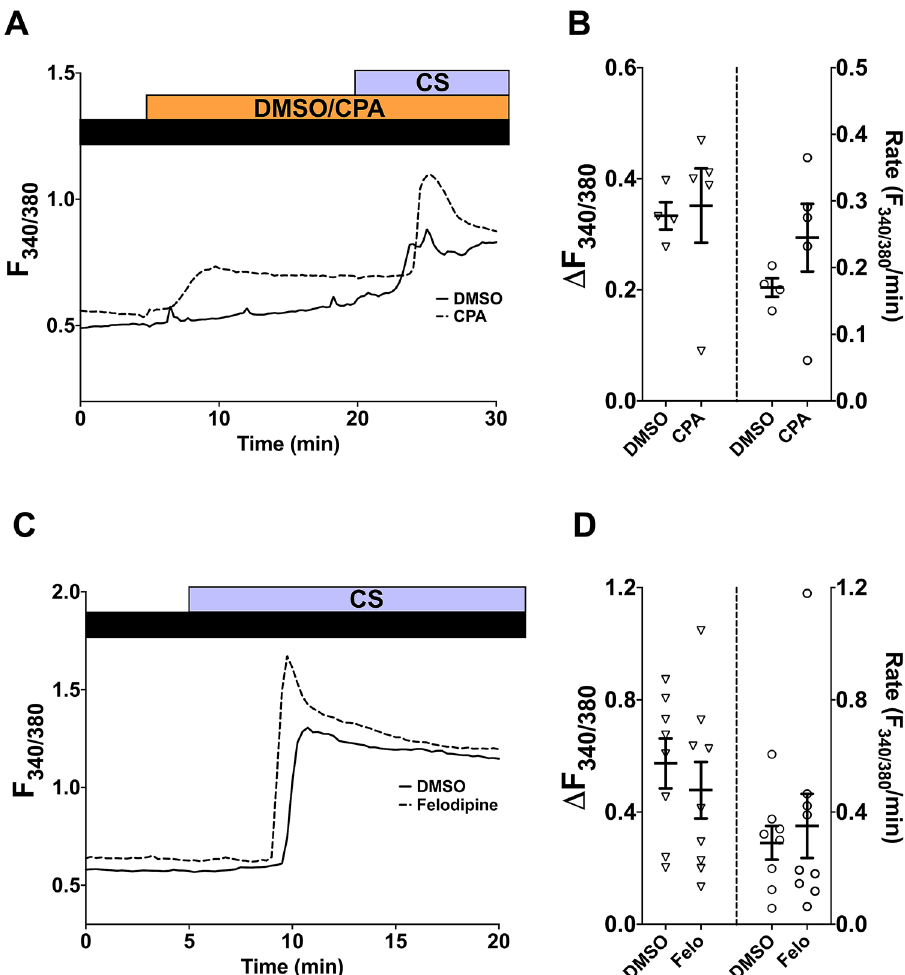
Figure 3. CS-induced Ca 2+ influx utilises a different pathway from SOCC and LTCC. (A,C) Representative Ca 2+ imaging traces from separate experiments tracking changes in [Ca 2+ ] i following puffing one whole cigarette after 15-min treatment with 10 µM CPA (A) , or after 10-min pre-treatment with 1 µM felodipine, which was also present throughout the experiment (C) . Equal volumes of DMSO (0.01% for CPA, 0.001% for felodipine) were used for vehicle control. Experiments were run in the presence of 1 mM extracellular Ca 2+ (black bar). (B,D) Summary of amplitude and rate of CS-induced [Ca 2+ ] i changes corresponding to experiments in (A,C) , respectively, presented as mean ± SEM. Unpaired t-test was performed between the CPA-treated group ( B ; 2 independent donors; n = 4–5) or felodipine-treated group ( D ; 3 independent donors; n = 8–9) against the vehicle control group. *p <